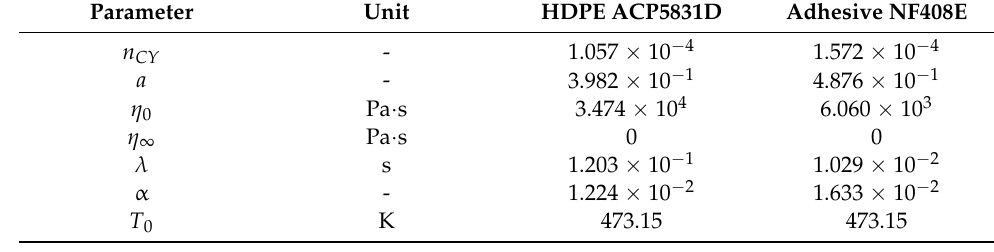
Table 2. Carreau-Yasuda parameters for HDPE ACP5831D and adhesive NF408E. Table 3. Tait parameters for HDPE ACP5831D and adhesive NF408E.